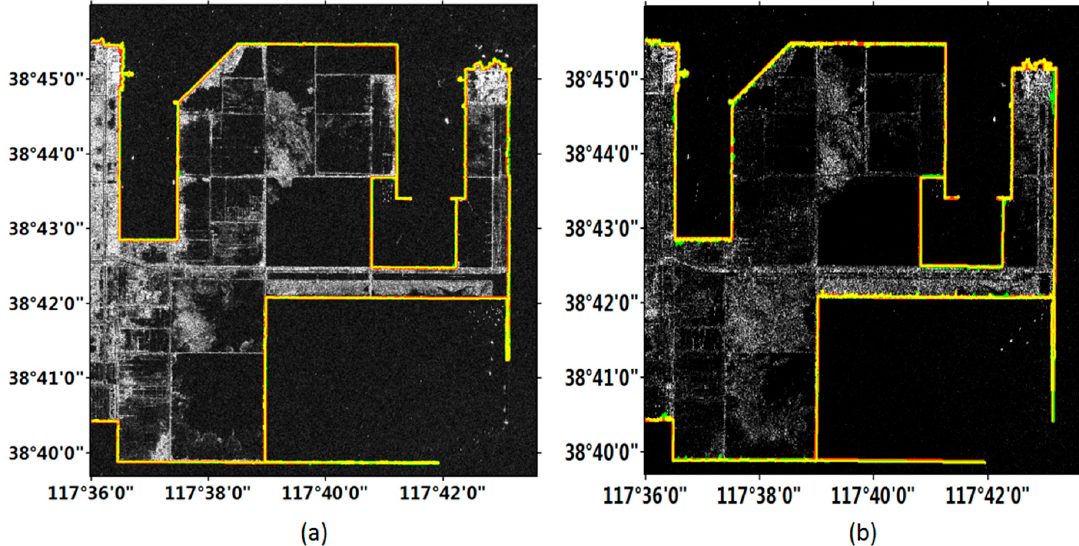
Figure 7. Experimental results of sub-region B in Figure 5. Red line represents the manually delineated coastline. Yellow and green lines represent the coastline detection results from the improved and original FCM methods, respectively. ( a ) Gaofen-3 image; ( b ) Sentinel-1 image.